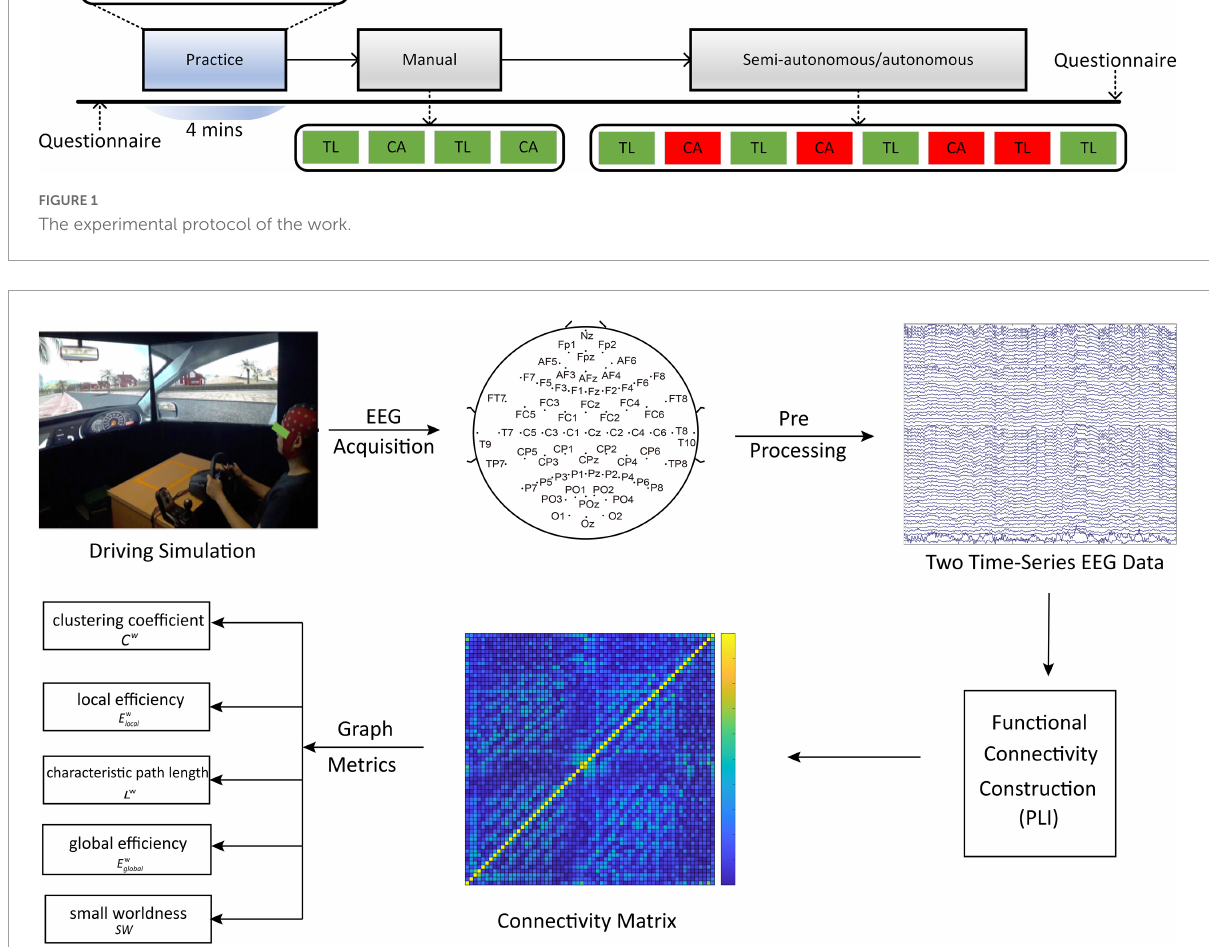
FIGURE2 Flow chart of functional connectivity graph metrics extracted after analysis of the EEG